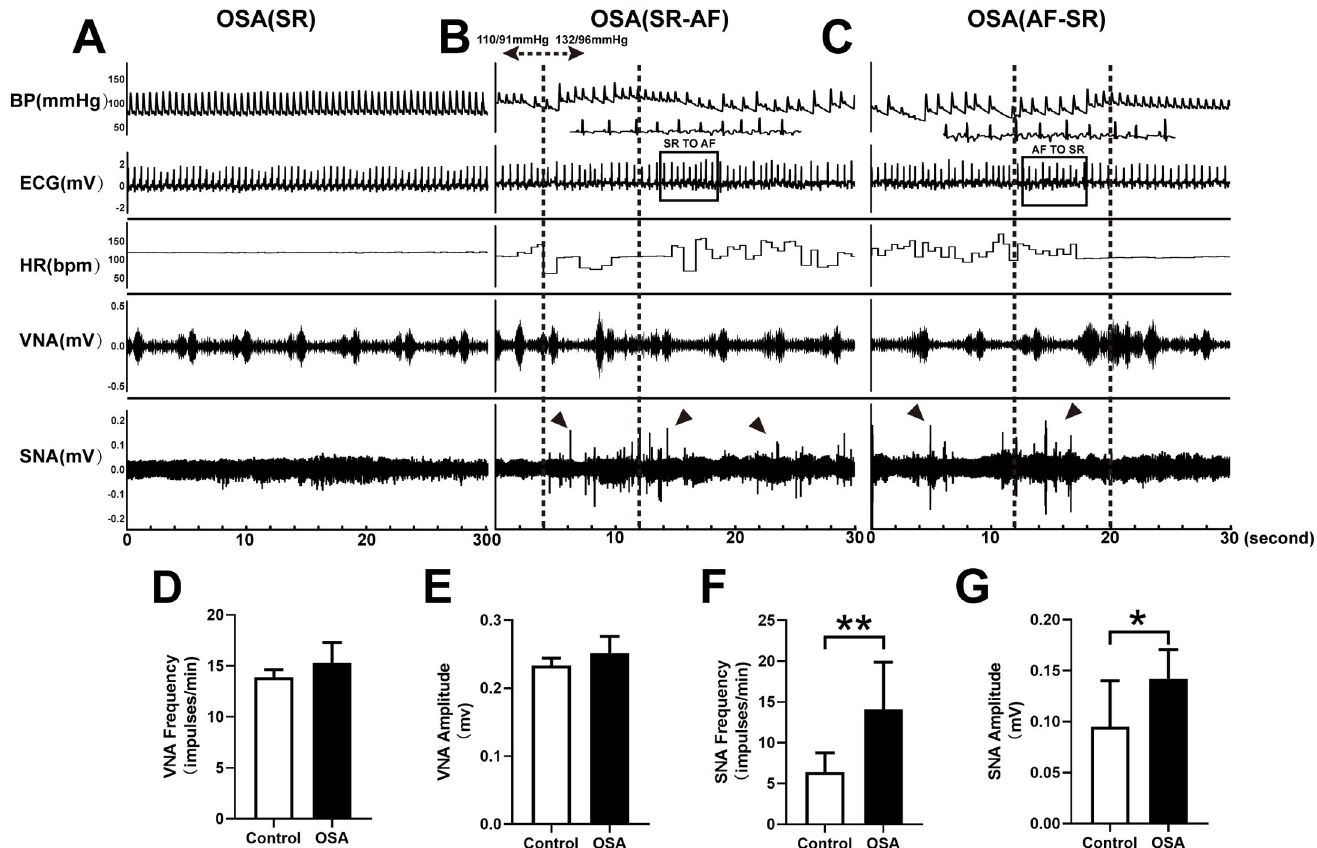
Fig 7. Recording and analysis of SNA, VNA in two groups. (A) In the OSA group, simultaneous recordings of SNA, VNA, ECG, HR, and BP in SR. (B)SR to AF. (C) AF to SR. (D) Nerve discharge frequency of the LVN. (E) Nerve discharge amplitude of the LVN. (F) Nerve discharge frequency of the LSG. (G) Nerve discharge amplitude of the LSG. Arrows: sympathetic discharge; Abbreviations: AF: atrial fibrillation; SR: sinus rhythm; ECG: electrocardiography; VNA: vagal activity; SNA: sympathetic activity; HR: heart rate; BP: blood pressure; LSG: left stellate ganglion; LVN: left vagal nerve. � P < 0.05, �� P < 0.01 compared to control group.